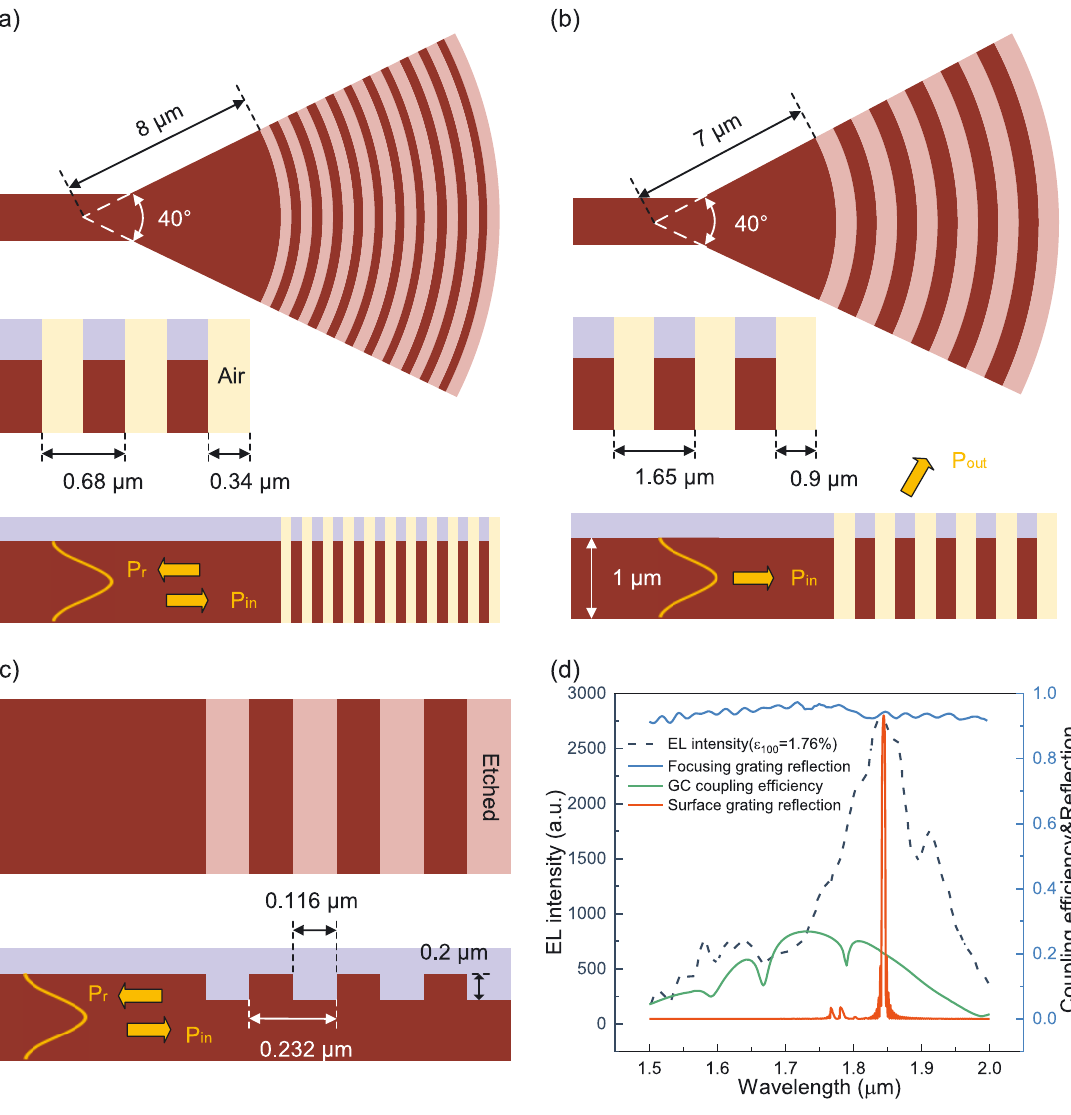
Figure 2: Schematics of gratings and the corresponding characteristics. (a) Ocusing DBR grating. (b) Grating coupler. (c) Surface DBR grating. Dimension parameters are marked. (d) Coupling efficiency of grating coupler, reflection of focusing grating and surface grating and their alignment with the EL spectrum of a Ge microbridge of 1.76% uniaxial tensile strain